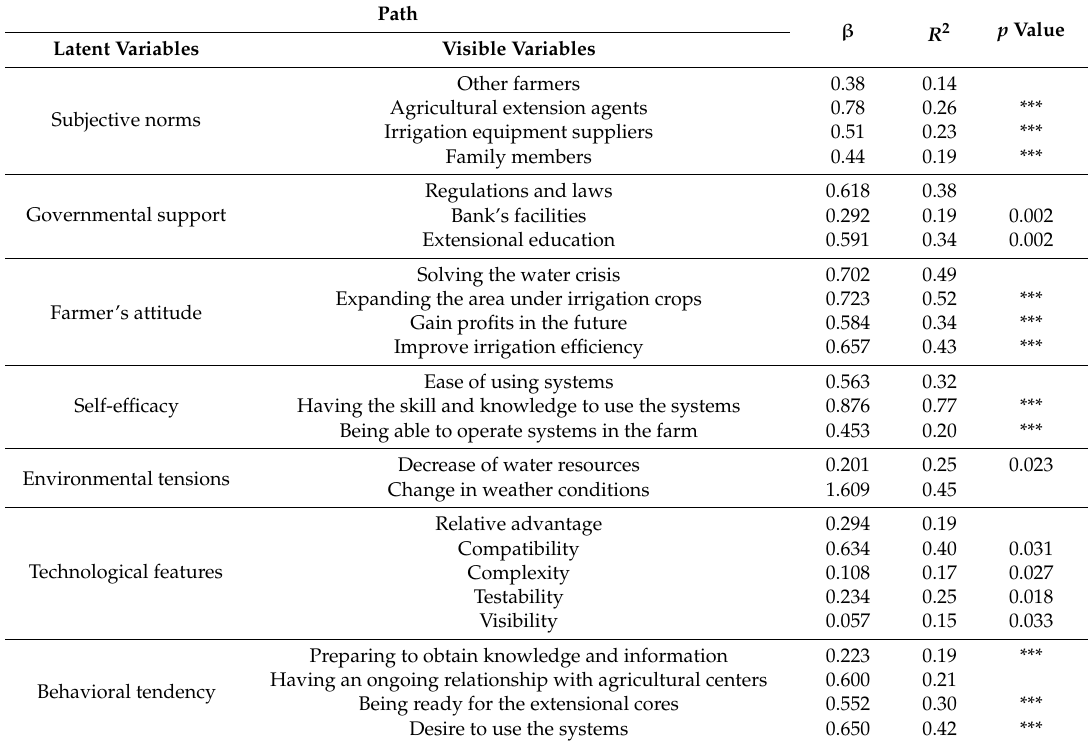
Table 5. Significance test of the relationships between latent variables and visible variables.